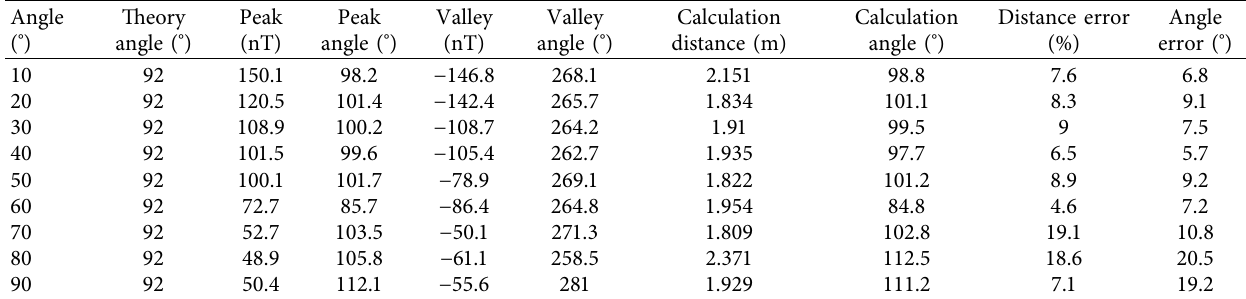
Table 4: Calculation result of different angles when the distance from sensor to casing is